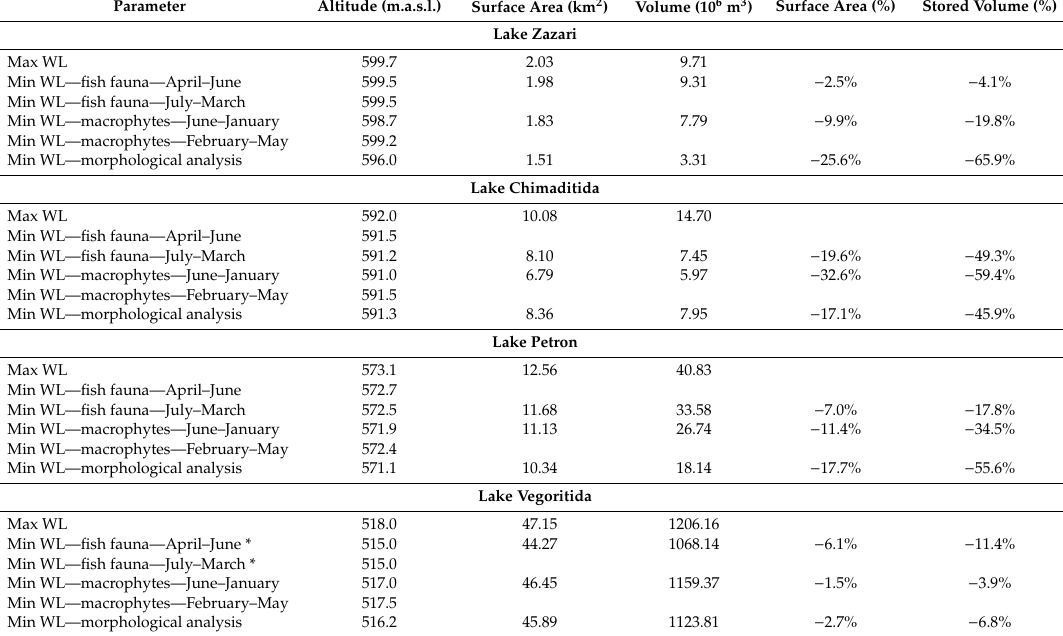
Table A2. Minimum suggested water level (WL) and corresponding surface area and stored volume, based on morphological analysis, macrophytes, and fish requirements in lakes Zazari, Chimaditida, Petron, and